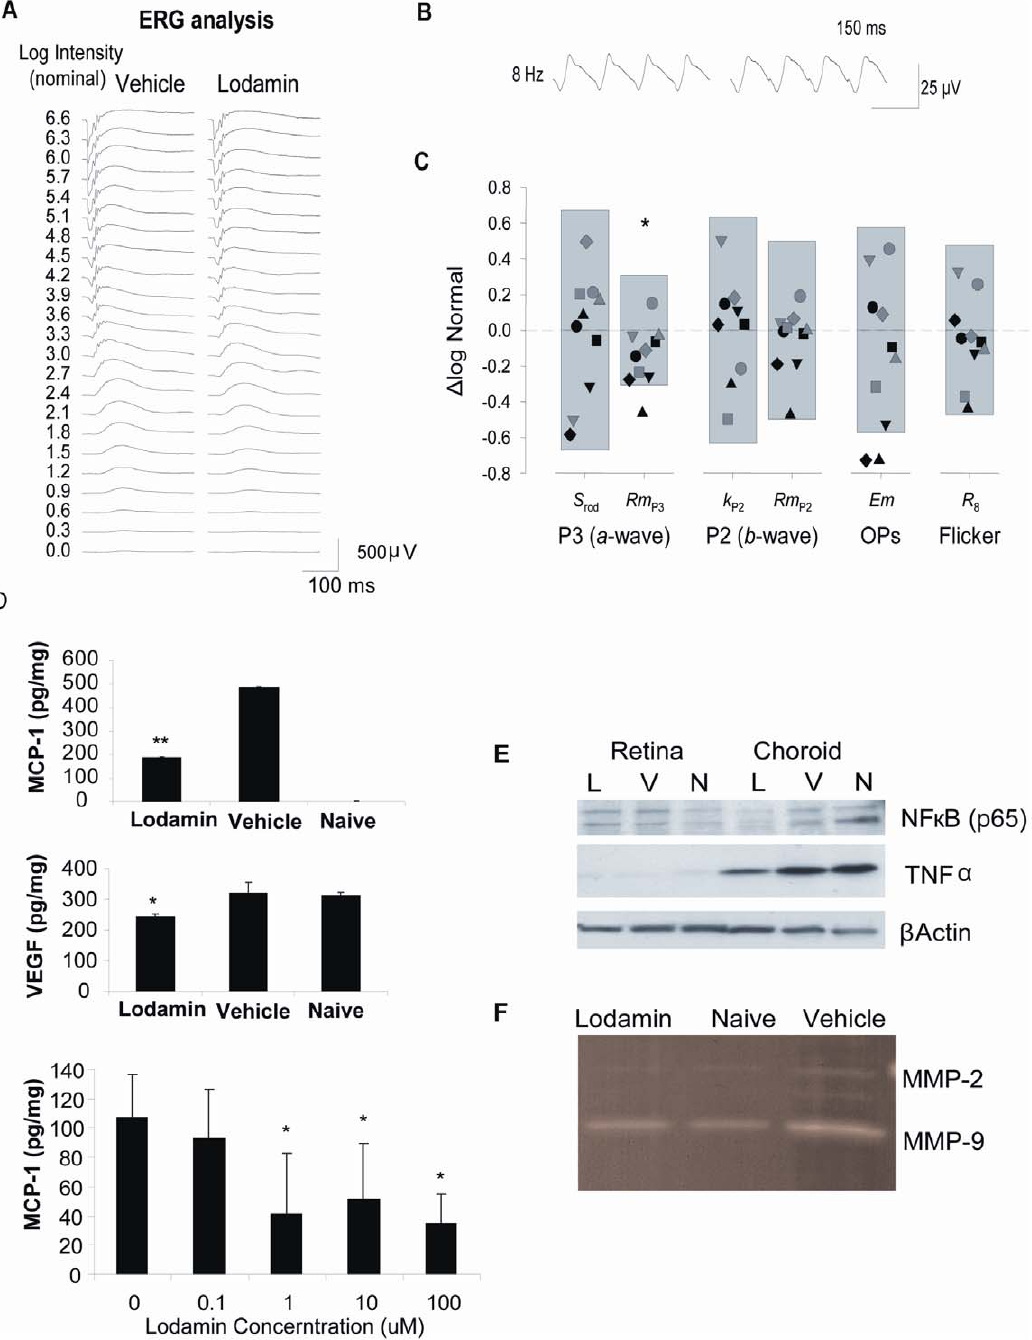
Figure 6. Retinal ERG and protein analysis post Lodamin treatments. Effects of intravitreal Lodamin on retinal function. ( A ) Representative full-field flash ERG responses from the eyes of mice 14 days after intra-ocular injection of vehicle ( left ) or 300 m g /eye Lodamin ( right ). ( B ) Representative responses to 8 Hz flicker ( C ) The 5 th to 95 th prediction limits for ERG parameters in vehicle treated rats are shown; the dashed line represents the normal mean of all the paramters. Symbols are parameters values of individual Lodamin-treated mice, and represent the same mouse in each column. Data are D LogNormal ( eq. 3 ). Only the saturating amplitude of the rod photoresponse ( Rm P3 ) differed significantly after Lodamin. ( D ) Effect of oral Lodamin treatment on protein levels of pro-angiogenic and pro-inflammatory factors. ( D ) Levels of MCP-1 and VEGF extracted from whole eye tissues from naı¨ve mice, mice treated with Lodamin (30mg/kg, oral every day for 7 d) or vehicle (same equivalent amount of mPEG-PLA micelles). Data of ELISA assay are presented as a mean of pg/ml concentration 6 SD (n=6, * P , 0.05, t-test). Bottom: ELISA quantification of secreted MCP-1 from RPE to the medium post 24 h incubation with Lodamin at different doses (0.1–100 nM TNP-470 equivalent). ( E ) Western blot protein analysis of samples of tissue lysis of retina or choroid of the different treatment groups: N=naı¨ve mice, V=vehicle treated mice, L=Lodamin treated mice. Factors detected are TNF a (26 kDa) ( F ) Zymogram showing MMP-2 and MMP-9 activity in ocular tissue following oral Lodamin treatment of mice (30 mg/kg/day 7 days).